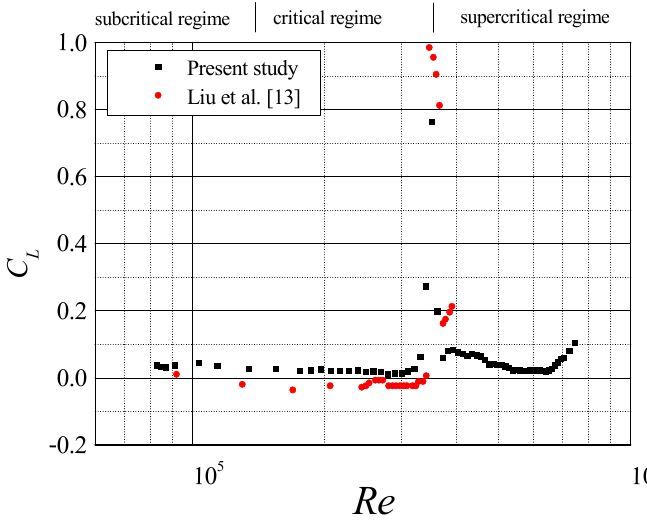
Figure 18 . Lift coefficient of circular cylinder in the smooth flow. Figure 18. Lift coe ffi cient of circular cylinder in the smooth